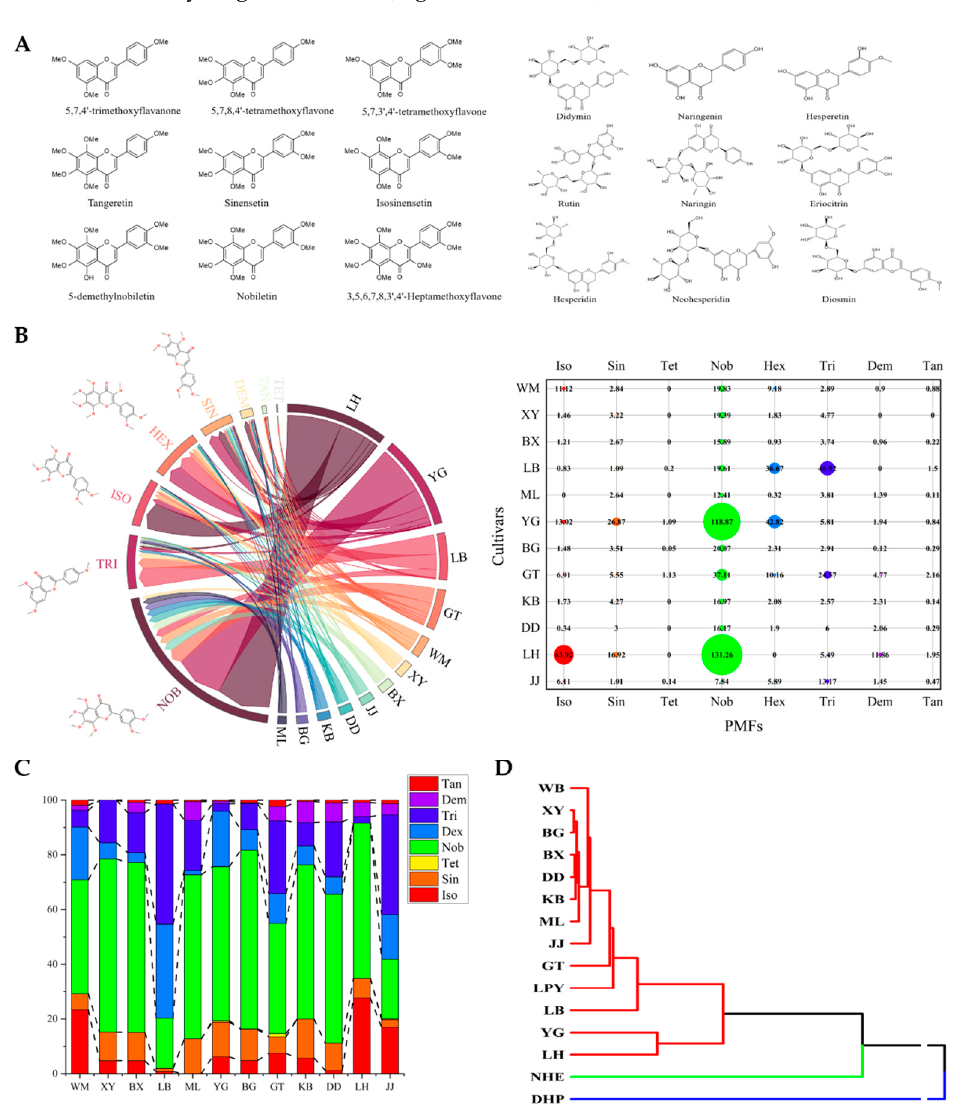
Figure 1. The PMF content in sour orange. ( A ) The structures and the names of flavonoid standards used in this study. ( B , C ) The absolute and relative content of PMFs in sour orange. ( D ) Clustering analysis of Citrus taxa based on PMF